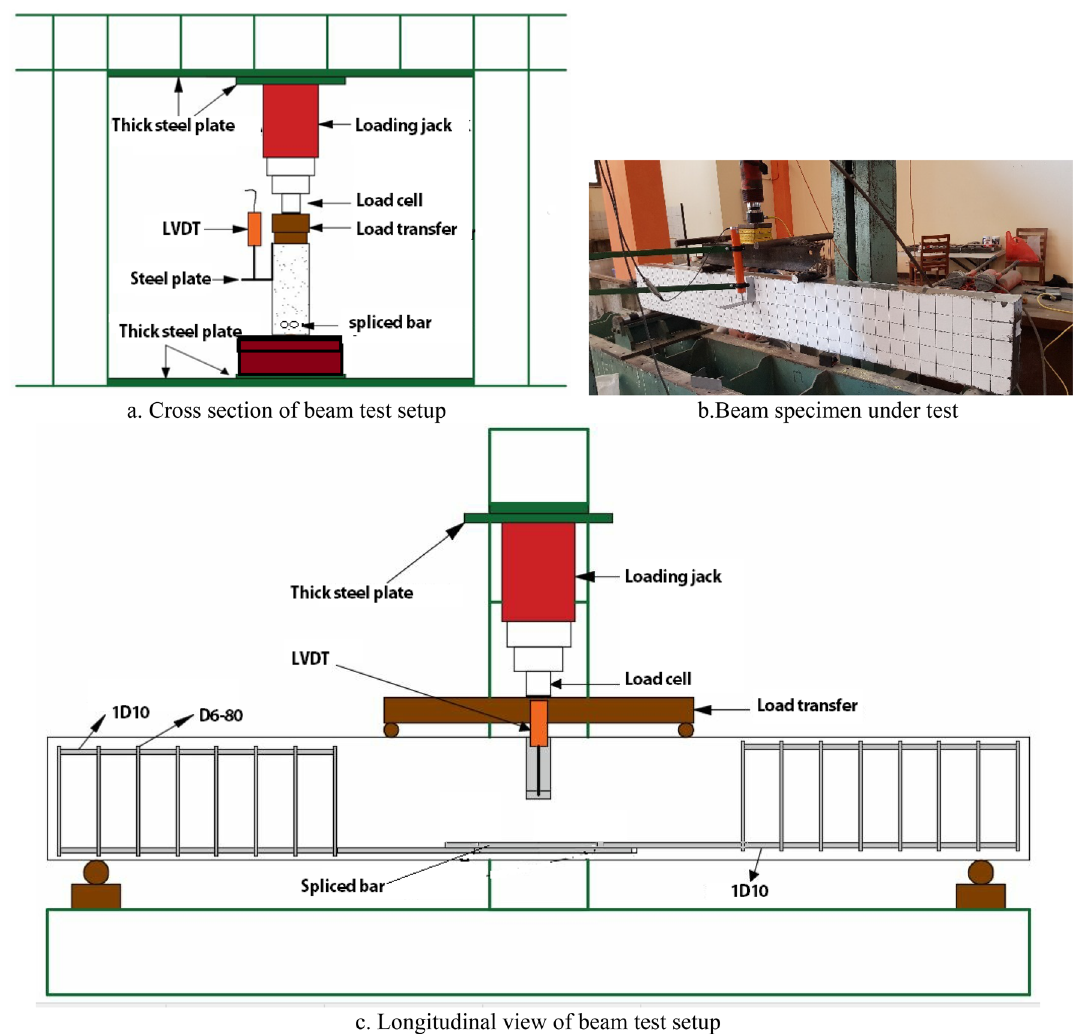
Fig. 2 Overview of four-point loading test on beam